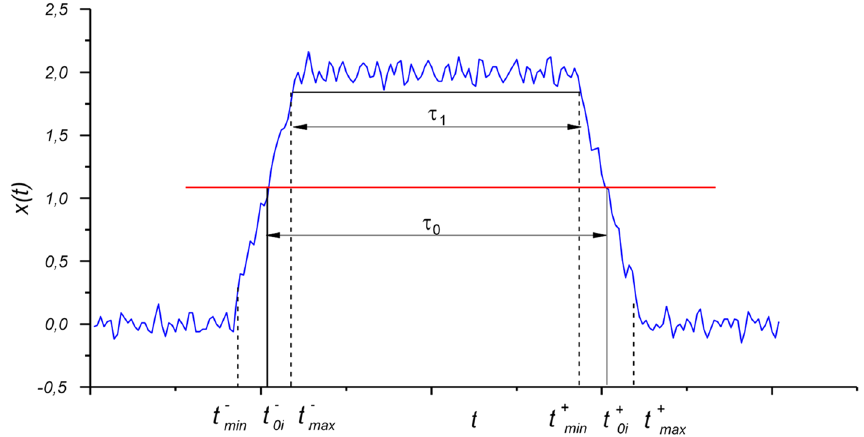
Figure 1. Observed process x(t) in the form of the impulse on the noise